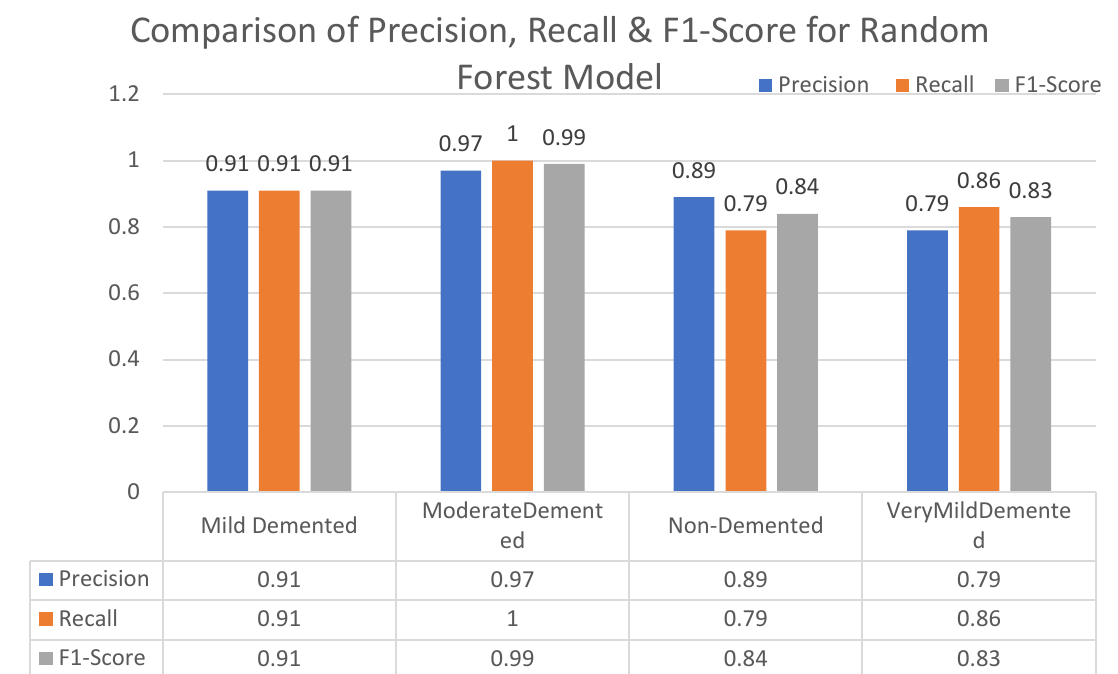
Figure 10. Visualization of Diagnostic Test for Random Forest Model.